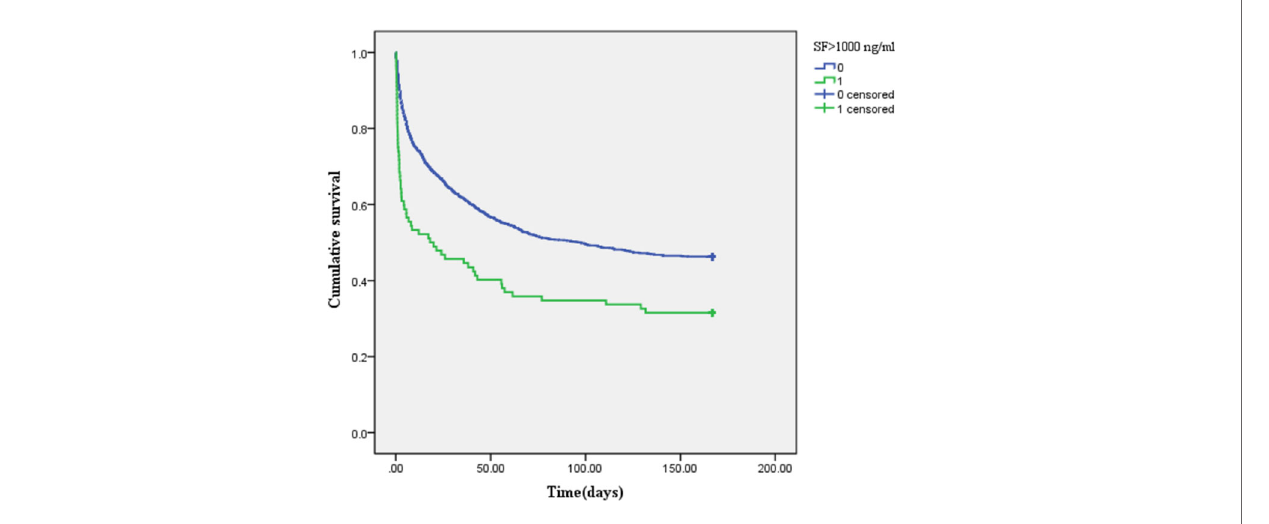
FIGURE 3 | Kaplan – Meier survival curve of patients in the different serum ferritin (SF)-level groups (1 represents SF-increased group: >1,000 ng/ml, and 0 represents SF-normal group: ≤ 1,000